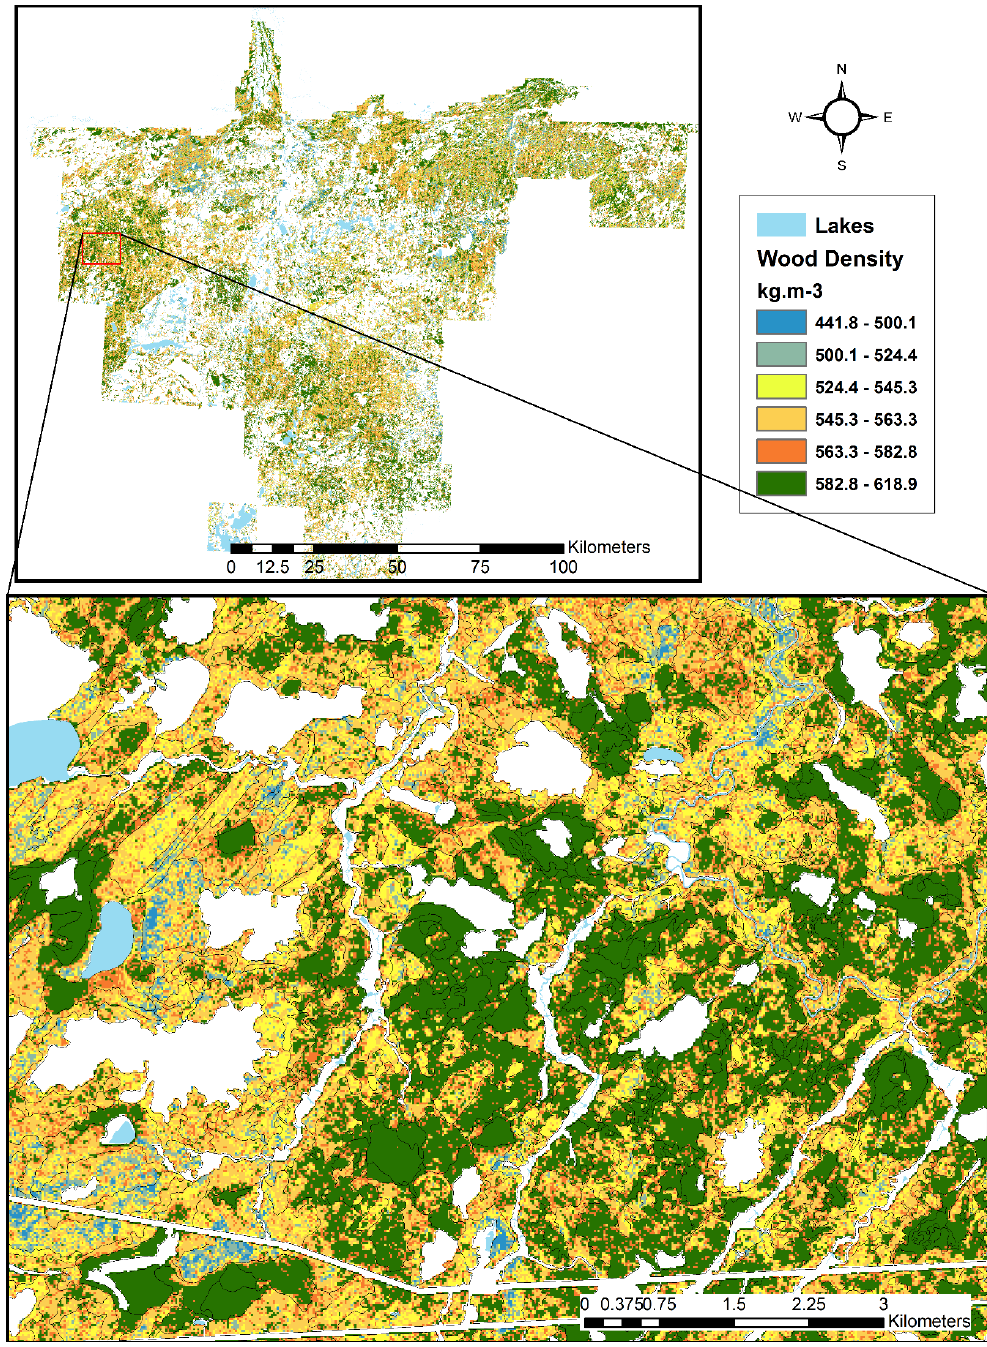
Figure 6. Predictive raster map (20 m × 20 m) of average wood density (kg ⋅ m − 3 ) of black spruce trees in representative stands across the Hearst Forest, Ontario, Canada. The upper panel represents the total 1.3 million ha area within the Hearst Forest, the lower panel is an enlarged portion of the predicted density raster. White ‐ colored polygons are non ‐ forested area. A large amount of unexplained variability still exists in our model. This is due to the fact that there is a large variation in wood properties between individual trees. These variations could be related to differences in age, site, genotypes, and management [35,36]. There is substantial variation